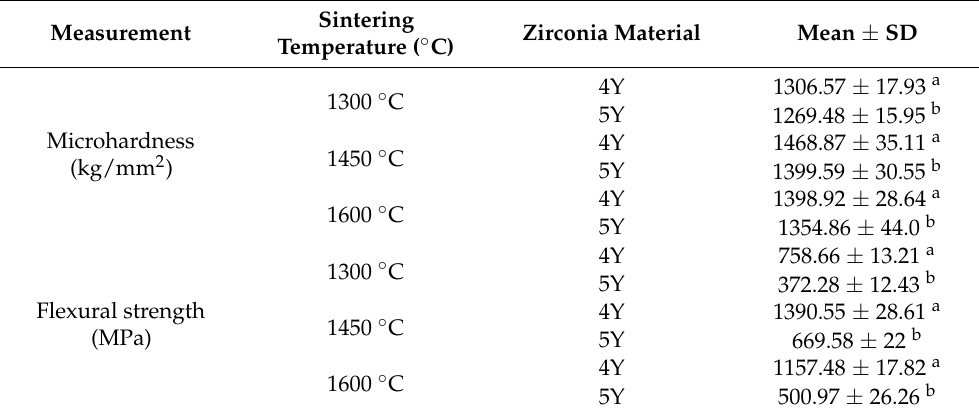
Table 2. Results of the T-test comparing the mean flexural strength and Vickers microhardness of zirconia materials at the same sintering